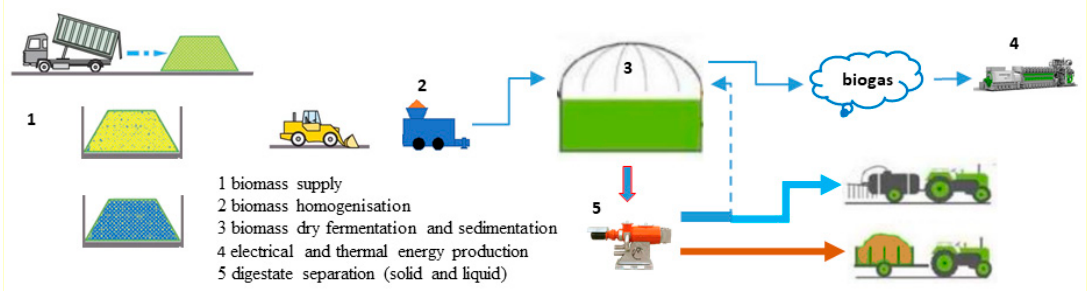
Figure 3. Steps of the dry Anaerobic Digestion process carried out inside the bioreactor built up by AB Group agricultural company in Vittoria (Ragusa).